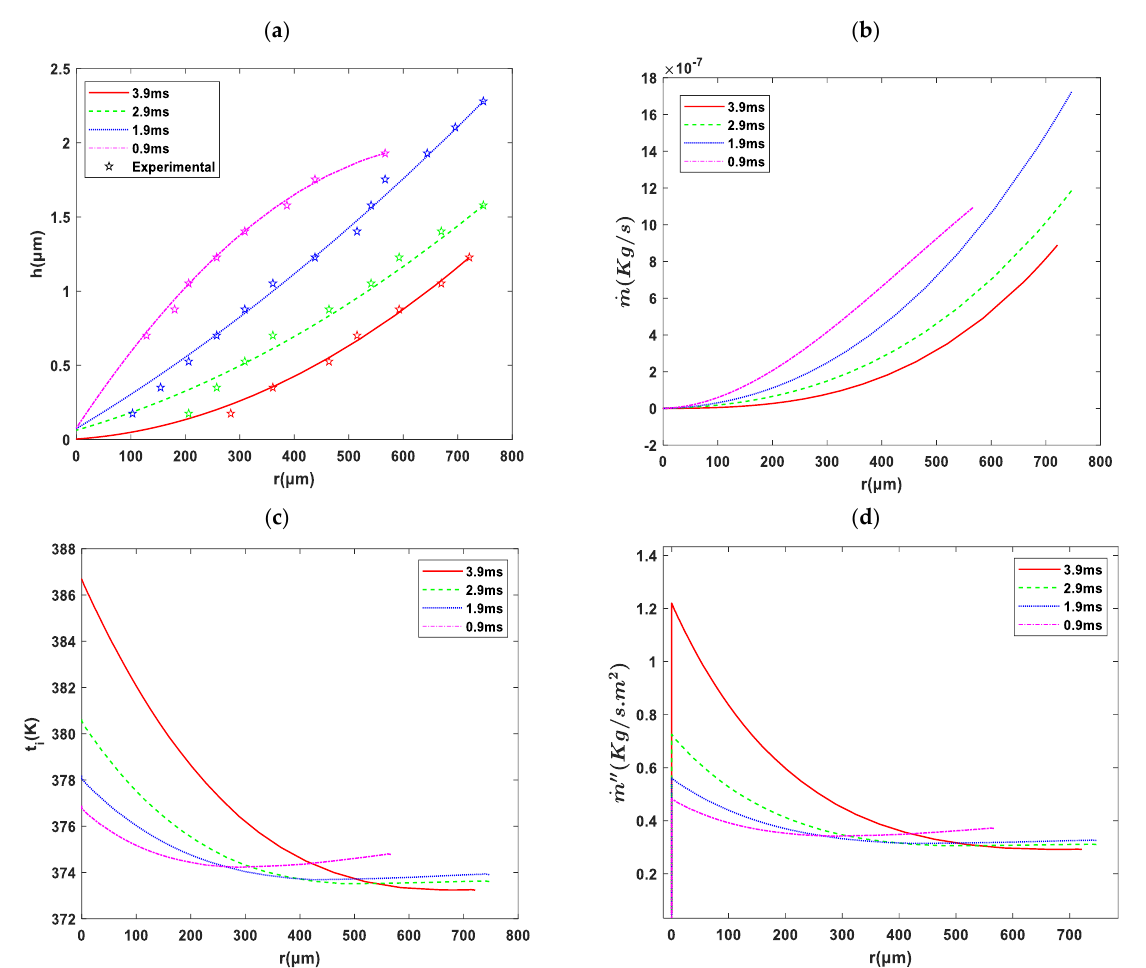
Figure 12. Radius evolutions of ( a ) film thickness; ( b ) mass flow rate; ( c ) interfacial temperature; and (d) evaporative mass flux for different time steps.